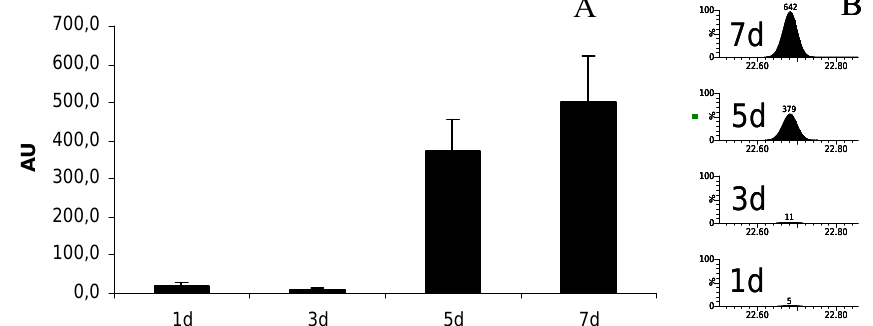
Figure 7. Relative quantification of the secreted metabolite putrescine.